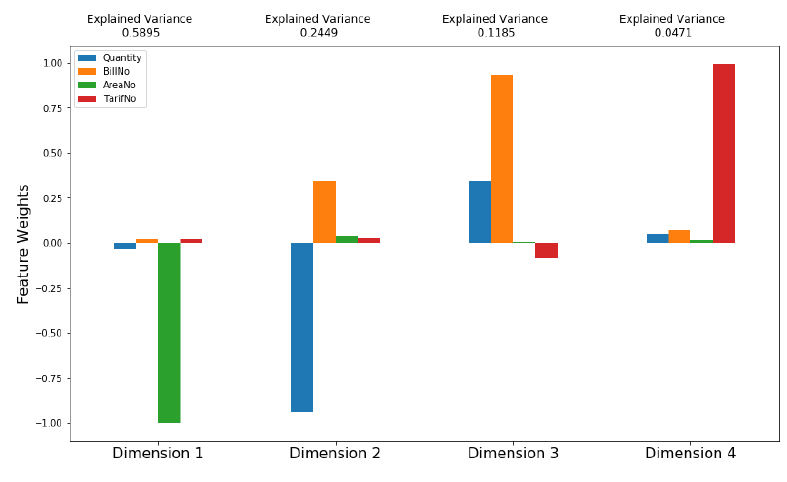
Figure 8. PCA dimensions.